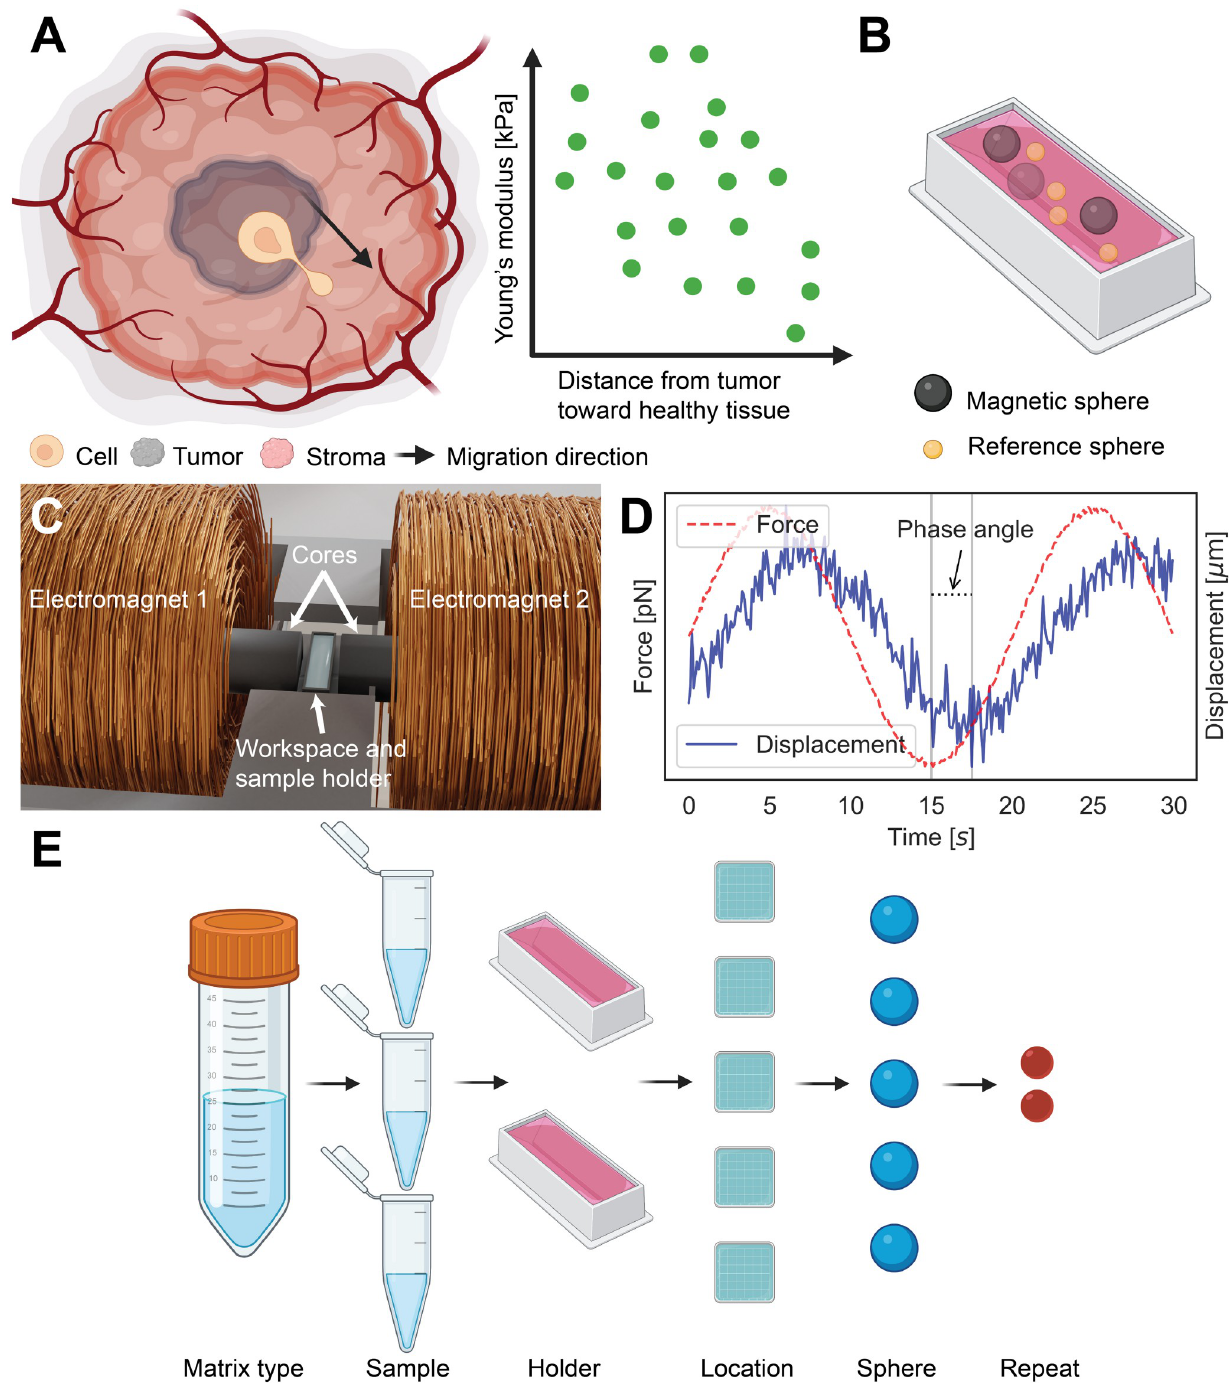
Fig 1. Microrheometry technique and experimental design for quantifying spatially differing microscale viscoelasticity. A : Breast-cancer tumor is surrounded by the stroma consisting of extracellular matrix. The cancer cells migrate out from the tumor, invade the stroma and further tissues during breast-cancer progression. In comparison to healthy tissues, the tumor tissues have often an increased Young’s modulus, and other viscoelastic properties also are altered [44]. B : Illustration shows a 3D culture matrix (in red) prepared into a sample holder. Two types of spheres, magnetic and reference spheres, have been introduced in the matrix during its preparation, enabling microscale viscoelasticity measurements using the microrheometer. C : The microrheometer system has two aligned electromagnets with cobalt–iron cores. The sample holders were placed into the working space between the cores. The electromagnets were driven by varied currents to exert forces on the magnetic spheres. D : Illustration of the oscillatory forces that were applied on a magnetic sphere. As a response, the magnetic sphere displaces in respect to reference, provided by reference spheres. The absolute shear modulus was